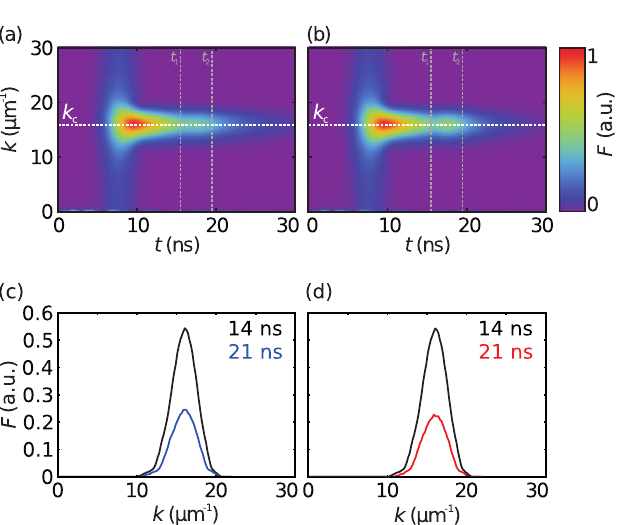
Figure 3. ( a , b ) Plots of the out-of-plane magnetization M z for simulations with an increase of the external magnetic field from µ 0 H 0 = 16mT to µ 0 H stop = 139 mT ( a ) and µ 0 H rev = 350 mT ( b ). ( c – e ) Closeups of of M z ( f ) Plots of the normalized temporal Fourier transforms at H 0 (black), H stop (blue), and H rev (red).